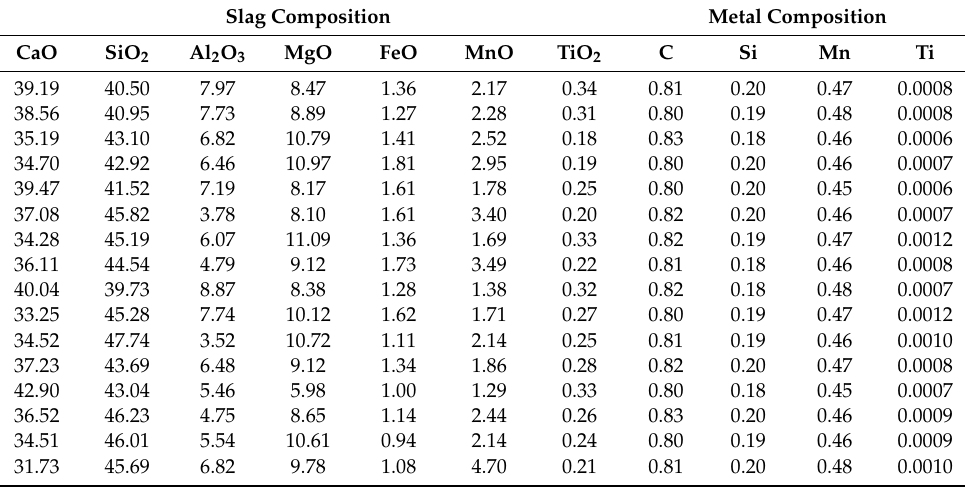
Table 2. Chemical components of liquid steel and slags at the end point of LF refining (wt %). Slag Composition Metal